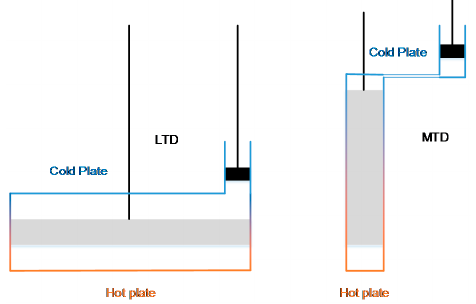
Figure 1. Heat transfer area in the low-temperature difference (LTD) and moderate temperature difference (MTD) gamma type Stirling engine.